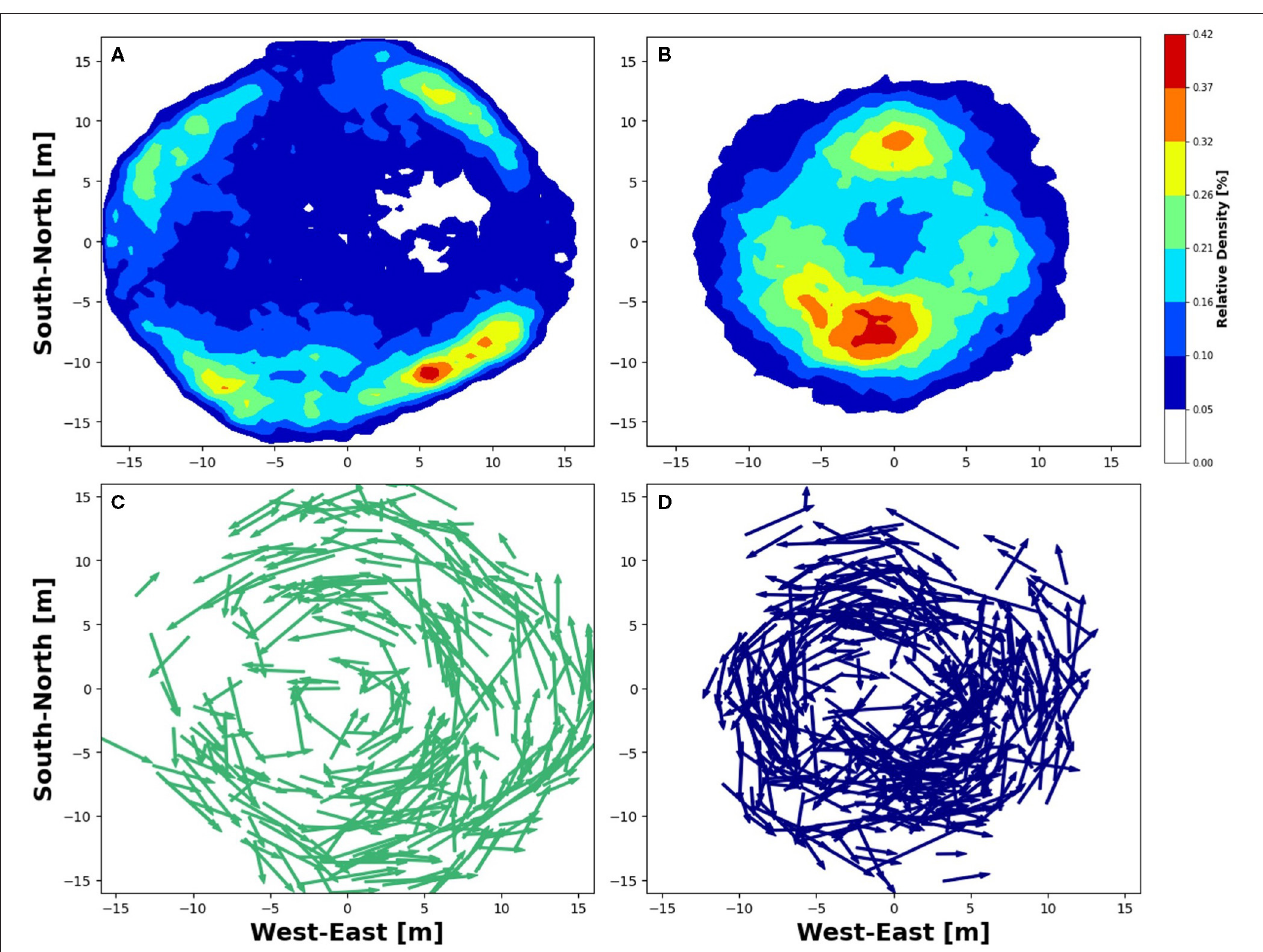
FIGURE 3 | Horizontal plots of two tagged fish. (A) Heatmap of fish 5 during October where blue shows low relative density [% occupancy] and warmer colours represent higher relative density. (B) Heatmap of fish 9 during October. (C) Vector plot of fish 5 during a 12-h period in October. (D) Vector plot of fish 9 during a 6-h period in